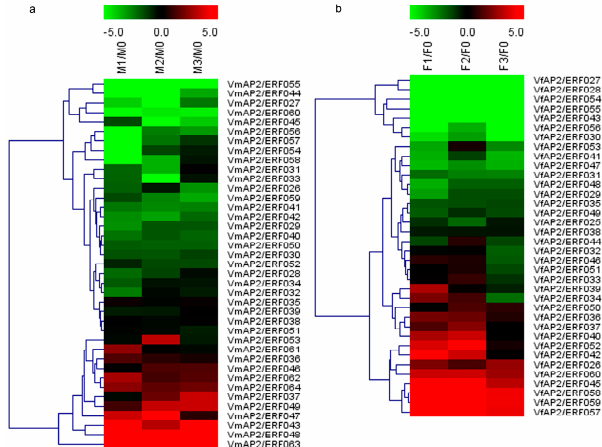
Figure 4. Expression profiles of ERF subfamily genes in response to F. oxysporum in Vernicia , namely ( a ) VmERF subfamily; and ( b ) VfERF subfamily. The heat map depicts expression patterns of ERF